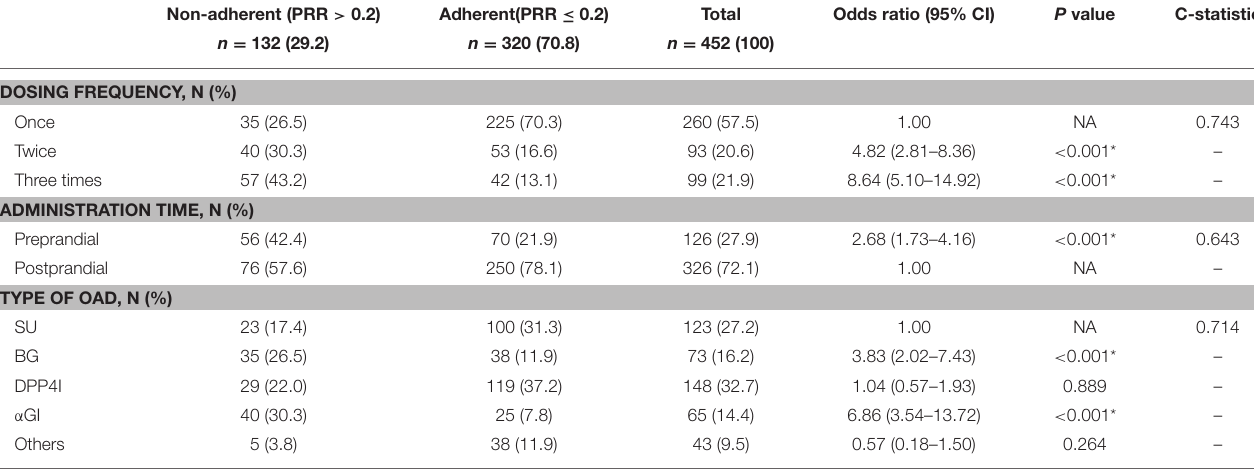
TABLE 4 | Factors contributing to OAD non-adherence associated with dosage and drug